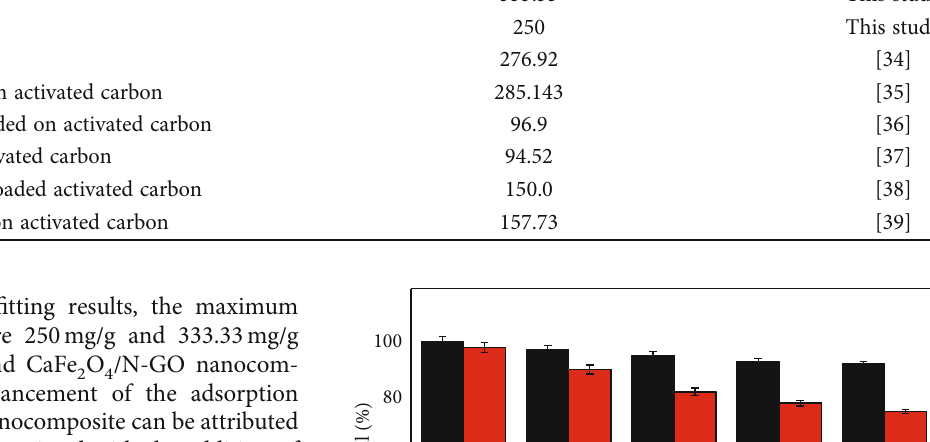
Table 3: Comparison between the removal of RO 12 over CaFe Adsorbent